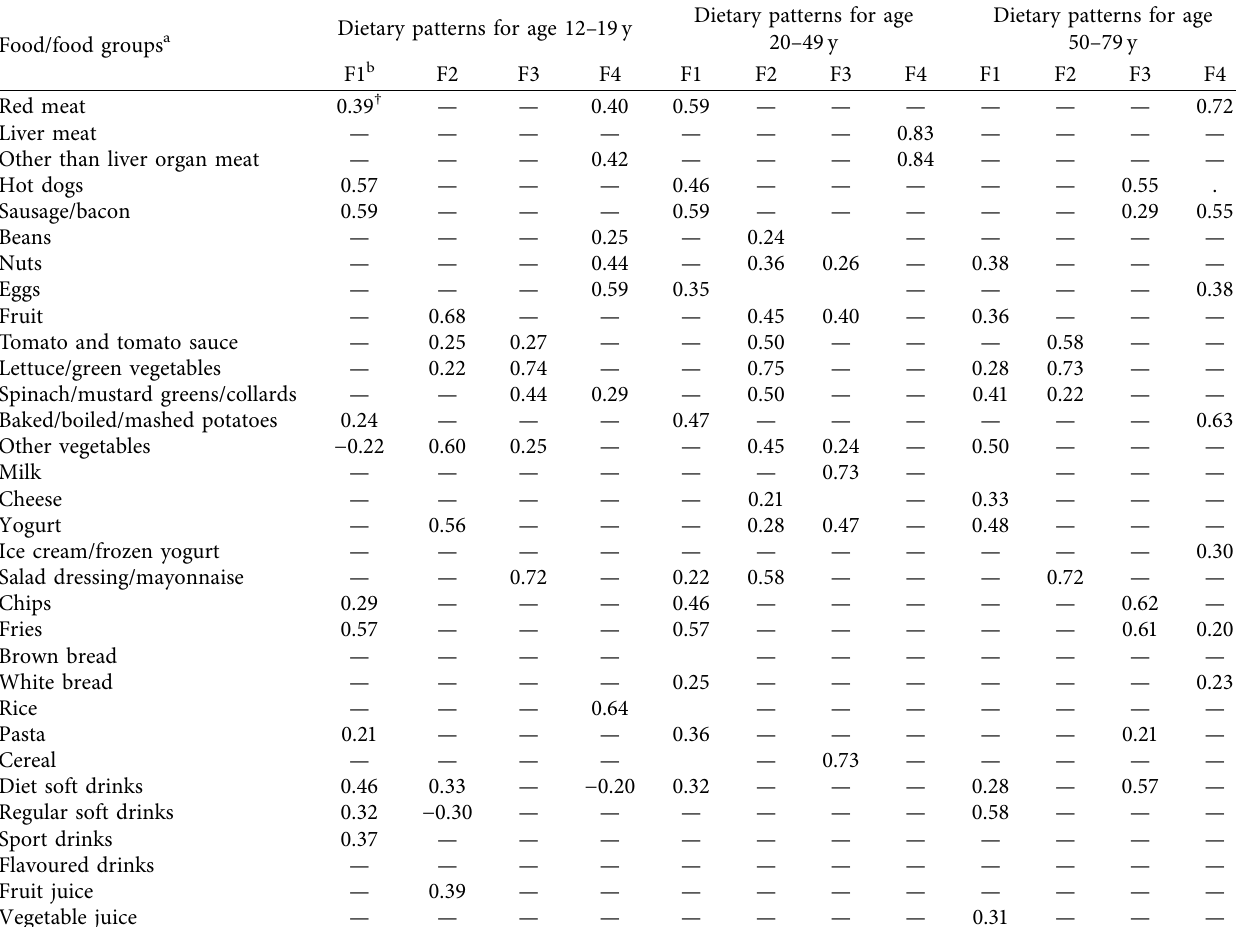
Table 2: Factor loadings from principal component analysis of dietary intake of Canadians 12–79 years of age, Canadian Health Measures Survey combined Cycles 1 and 2, 2007–11.